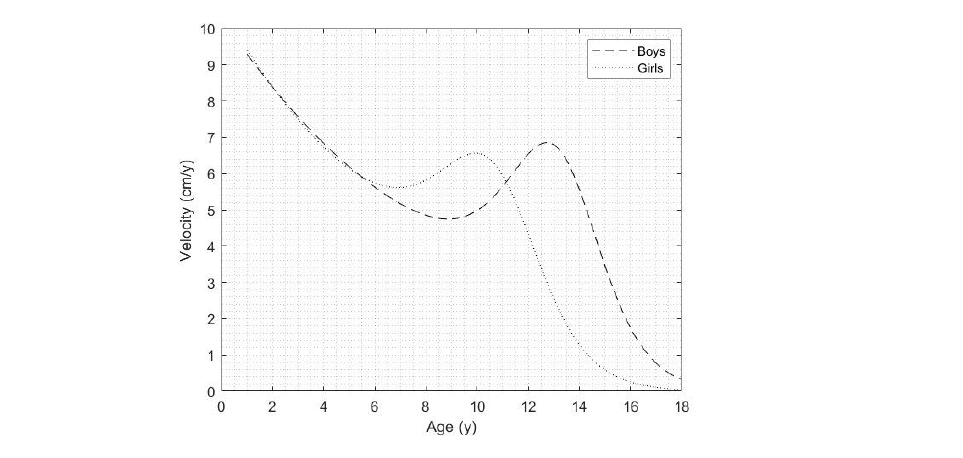
Figure 3. Peak height velocity curves of Colombian children and adolescents living at both alti- tudes by